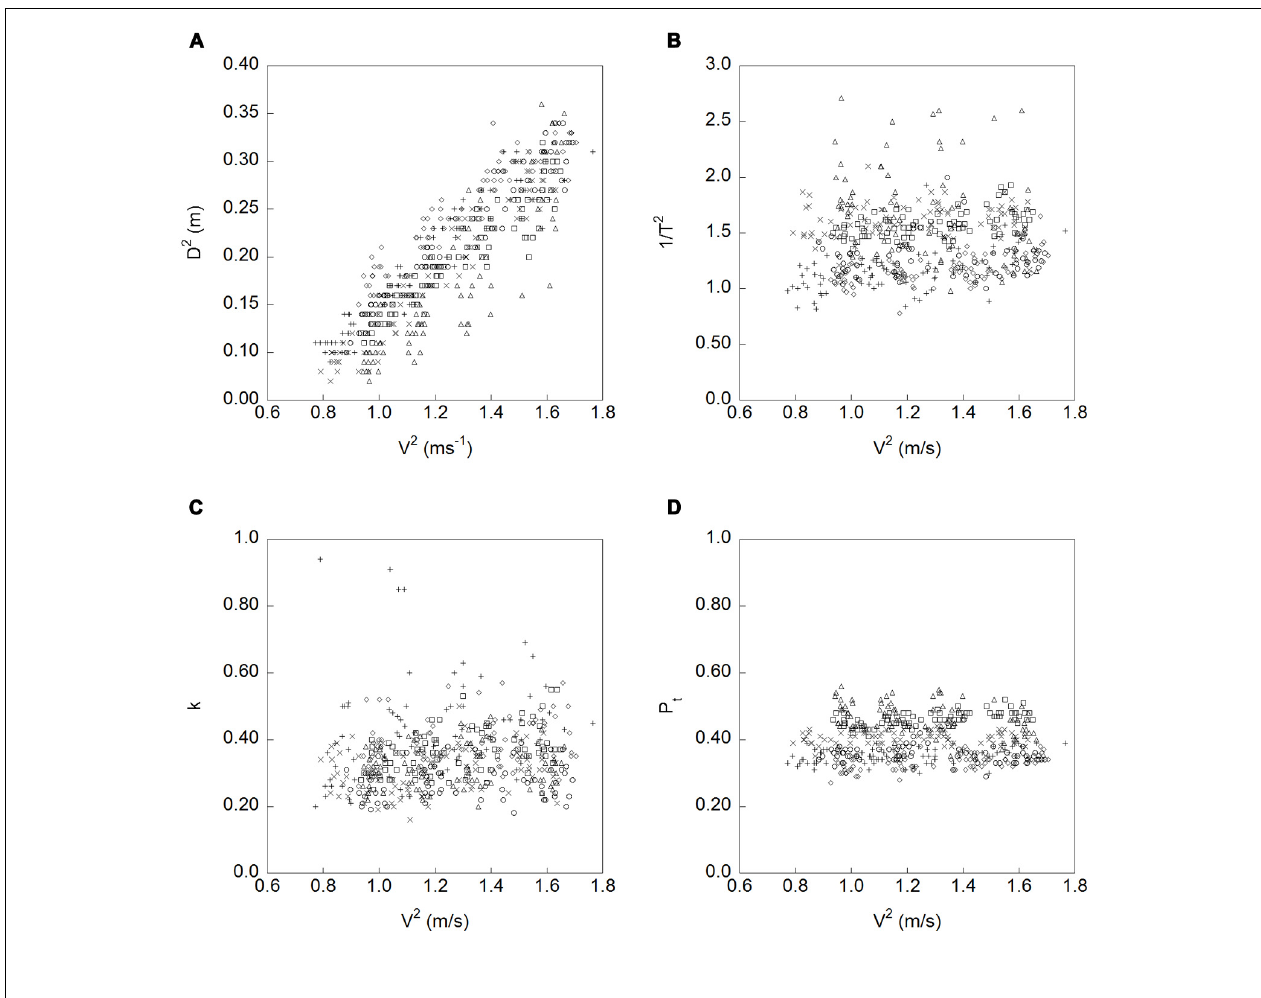
FIGURE 1 | Relationships between the velocity of the putterhead at impact (V 2 c ms -1 ) and; (A) swing amplitude ( D 2 ), (B) swing duration ( 1/T 2 ), (C) k a constant that denotes the shape of the putterhead